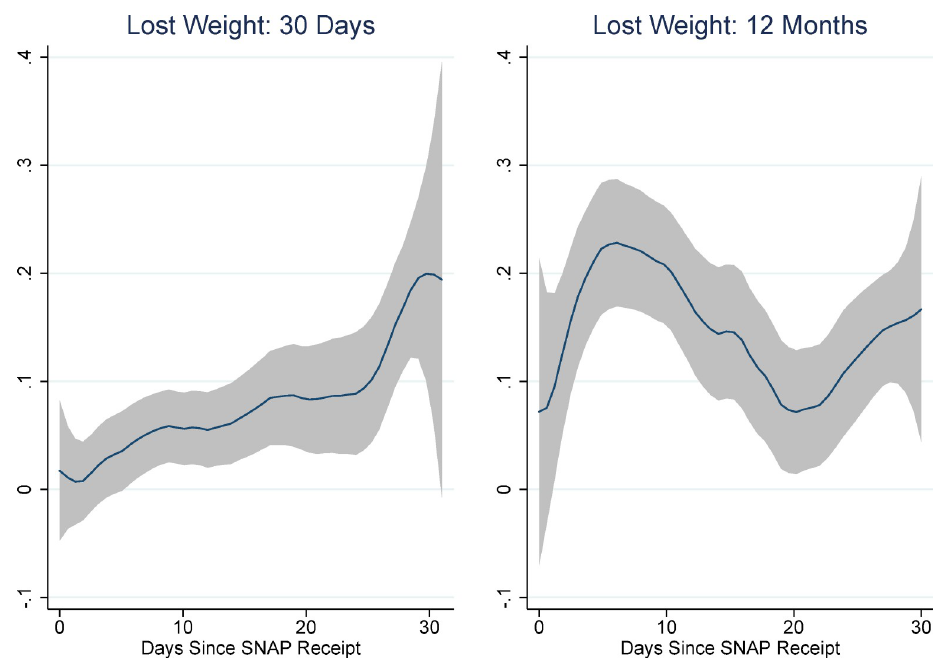
Fig 7. Individual 30-day and household 12-month responses to lose weight FSM item and days since SNAP. Source: Authors’ calculations using NHANES data. N = 647. Non-parametric regression estimates are weighted.